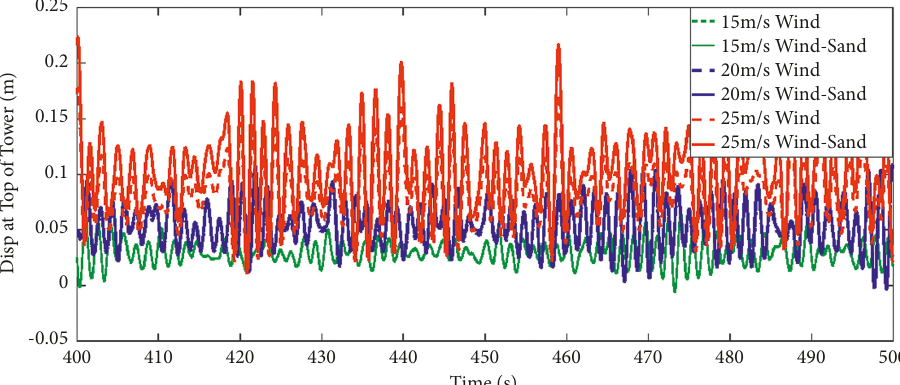
Figure 7: Displacement at the top of tower 2#.